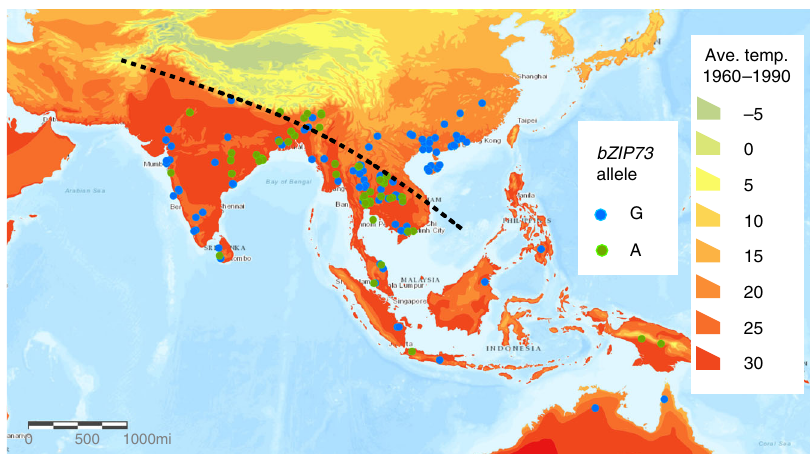
Fig. 6 Geographic distribution of bZIP73 Jap / Ind in O . ru fi pogon . The bZIP73 Jap (G) and bZIP73 Ind (A) alleles are labeled in blue and green dots, respectively. Each dot represents the geographic origin of a common wild rice sample. The major geographic distribution of the bZIP73 Ind (A) allele is separated by a black dotted line. Terrestrial surface temperatures averaged from 1960 to 1990 A.D. are shown as a heat map with scale bars in °C. Copyright © Esri.